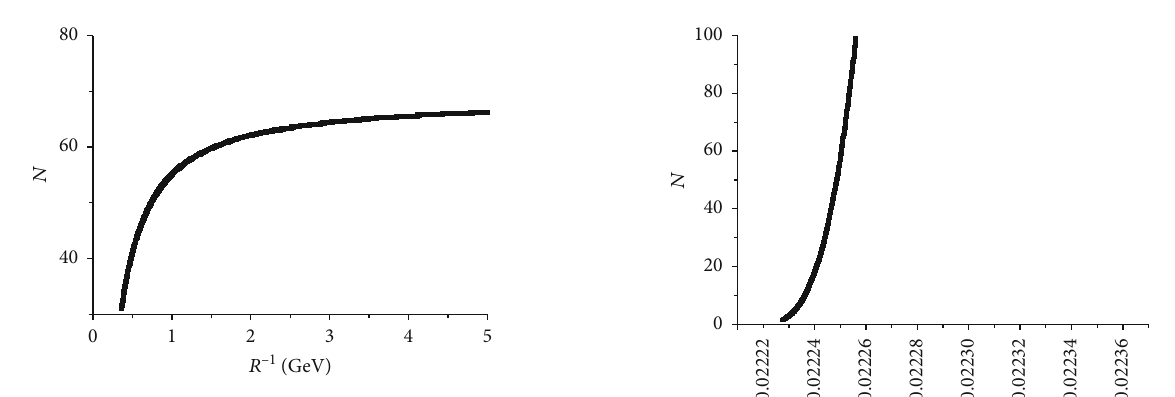
_ = 0 : 01 , R 0 Figure 4: The number of e -folds N in the logamediate in fl ation scenario as a function of R − 1 for R _ _ = 0 : 01 , R = 0 : 1 , λ = 10 , A = 1 , and f = 1/2 . R 0